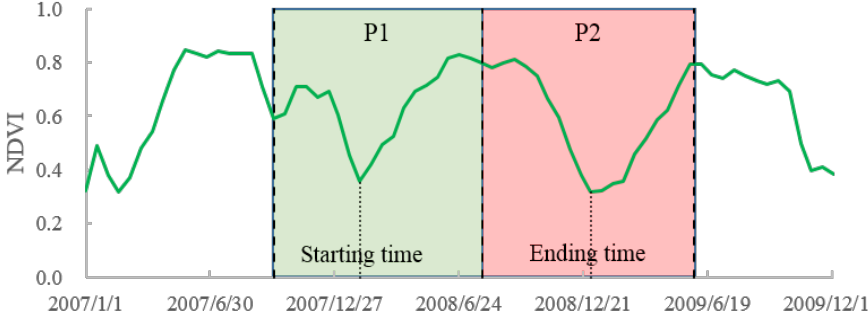
Figure 4. The temporal evolution of a representative pixel.